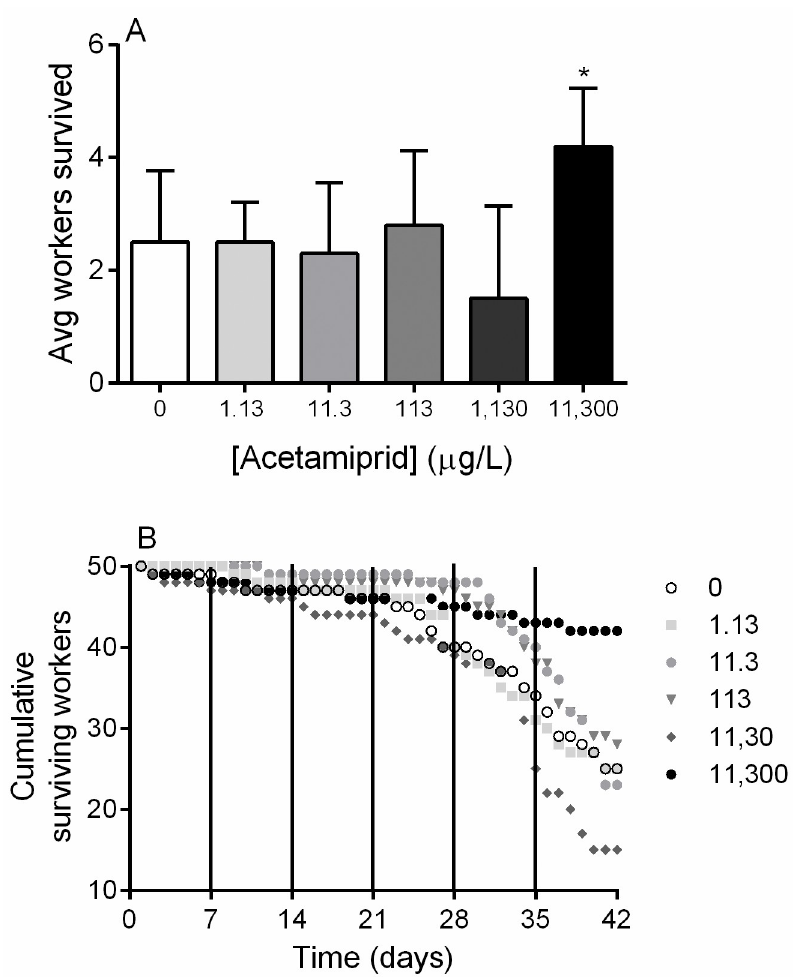
Fig 1. Microcolony founding worker survival. ( A ) Average worker survival at termination of the experiment. ( B ) Worker survival over time for each exposure group. Acetamiprid concentrations are expressed in μ g/L. Data shown as mean ± SD (n = 10). � denotes p <